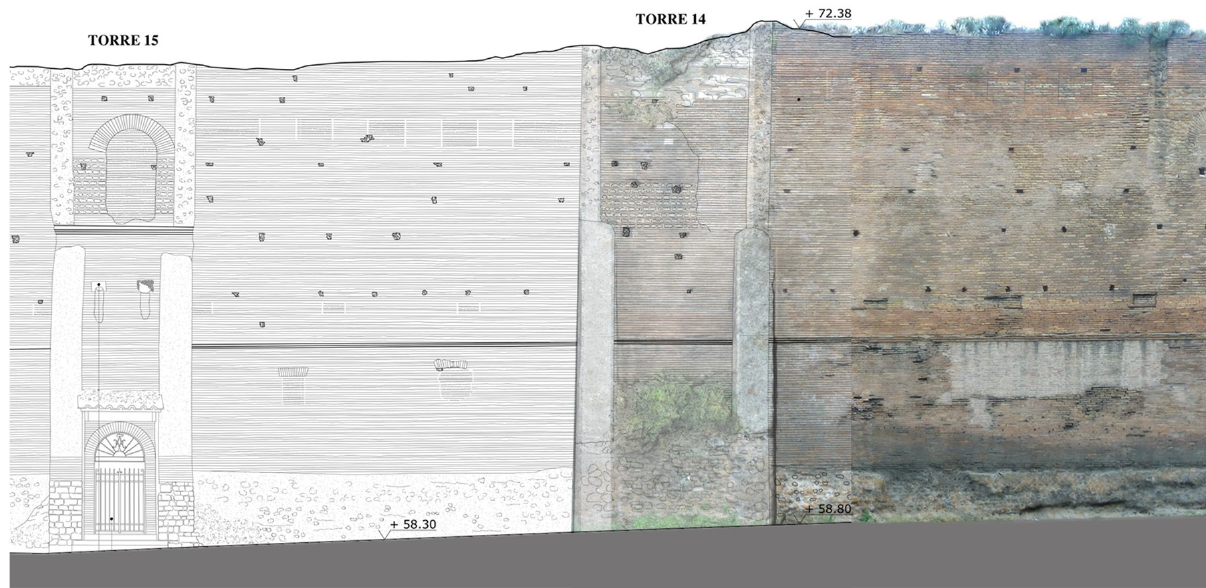
Figure 3. Front view, drawings and orthophoto. The 3D mesh model was used as base for the